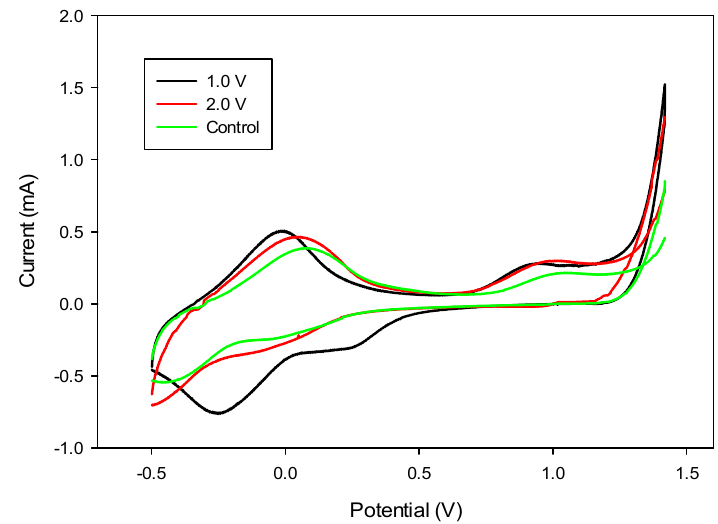
Figure 4. Cyclic voltammogram in the bulk solution for different applied voltages.